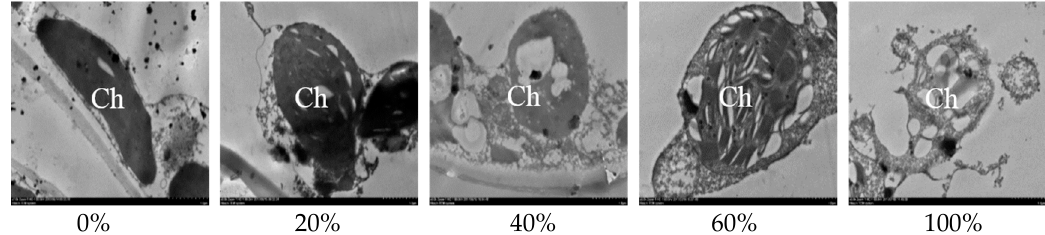
Figure 11. Chloroplast structure of wheat at different disease severity (DS) after